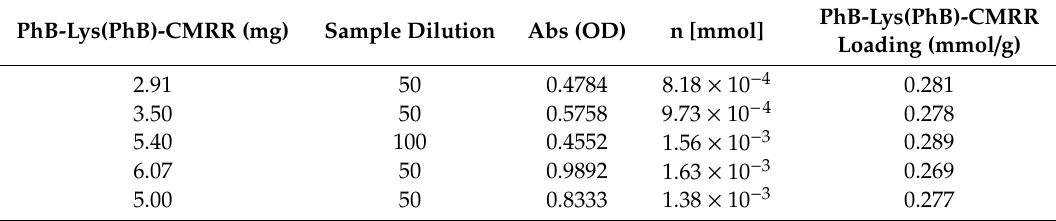
Table 1. Loading of PhB-Lys(PhB)-ChemMatrix ® Rink resin (M = 0.28 mmol / g, SD = 0.007).